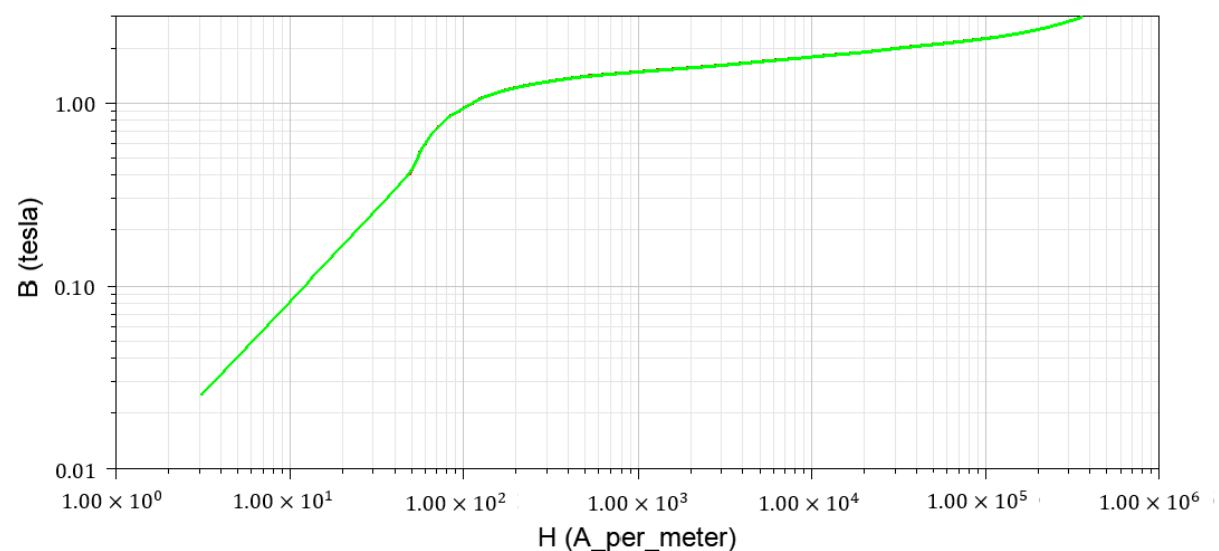
Figure 1. The magnetic nonlinearity of 50W250. The rotor yoke is made of steel sheets SXRE750, and its magnetic nonlinearity is shown in Figure 2. In this generator model, copper windings are used in the stator, and field coils are used in the rotor.